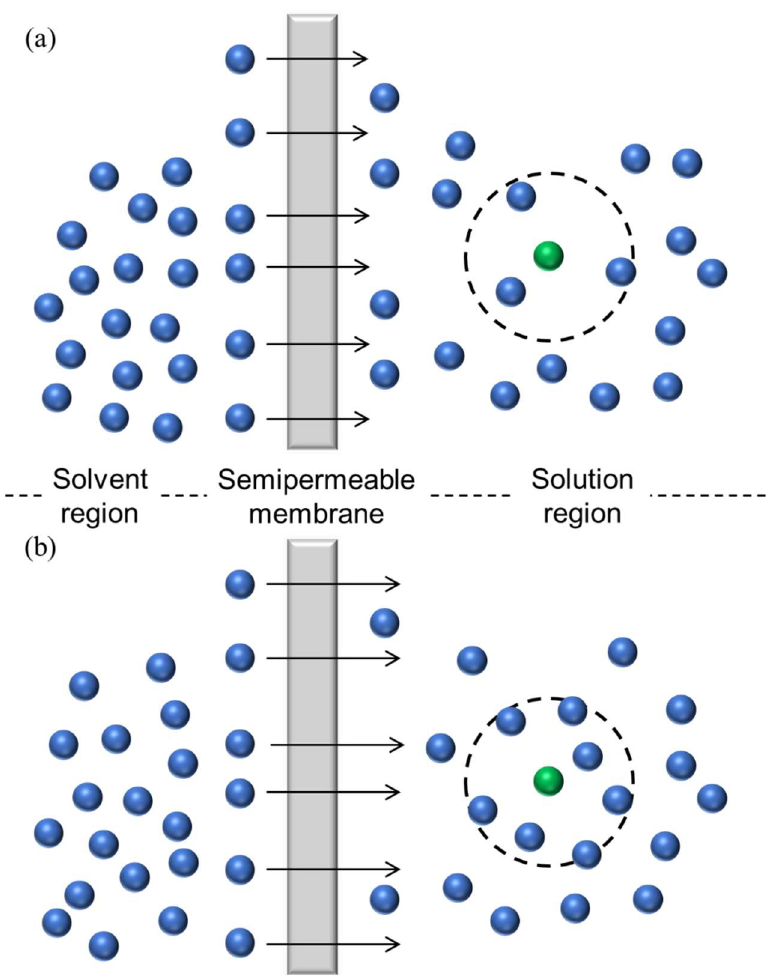
Figure 6. Illustration of the permeation when the ε value of the S Ar solute is as denoted in Table 1 in ( a ) and doubled in ( b ). The blue and green spheres represent the solvent and the solute,